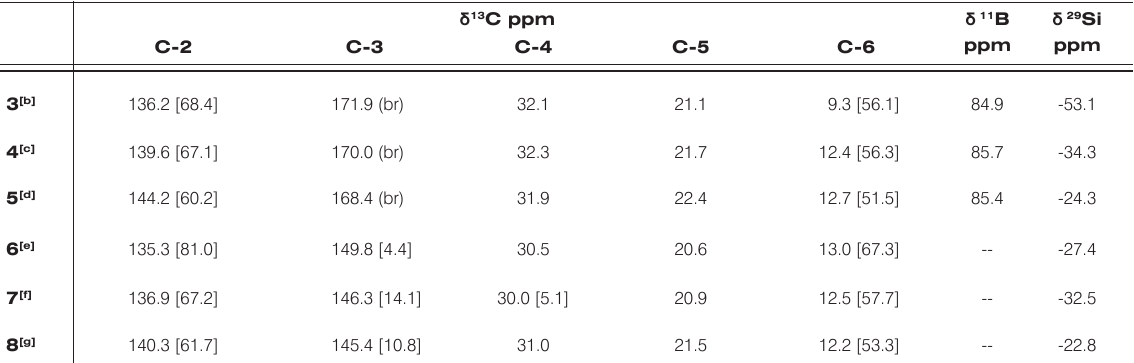
Table 1. 13 C, 11 B and 29 Si NMR data [a] of 1-silacyclohex-2-ene